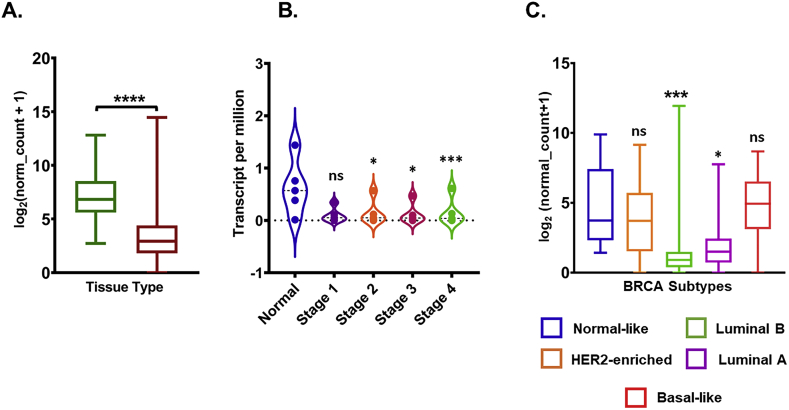
Gene expression level of ACE2 in breast cancer. (A) Box plots show the ACE2 mRNA expression in normal and tumor tissue Analysis was done with the UCSC Xena browser using TCGA TARGET GTEx study. (B) TCGA Breast cancer (BRCA) study was used to investigate the ACE2 in expression in distinct BRCA molecular subtypes. GraphPad Prism 8.4.2 was used to calculate statistical differences by unpaired t-test with Welch's correction. (C) Violin plot showing ACE 2 expression levels in BRCA tumor based on tumor stage via UALCAN database. (*P < 0.05, **P < 0.01, ***P < 0.001, ****P < 0.0001).